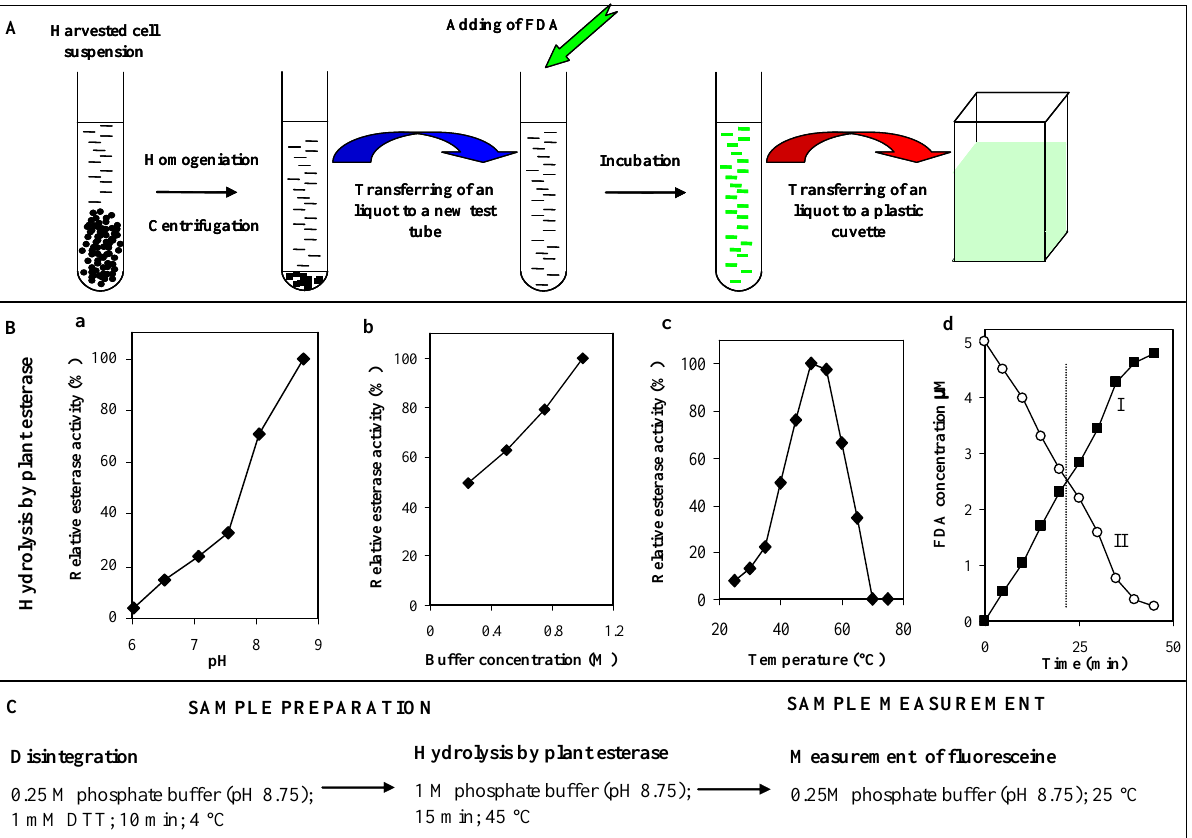
Figure 3. Optimization of the plant esterase determination. Scheme of a plant cells sample prior to analysis ( A ). FDA hydrolysis by plant esterases ( B ). The dependence of esterase activity of PE on pH ( a ), concentration ( b ) of phosphate buffer; and temperature ( c ). Relative esterase activity of 1.3 · 10 -5 IU (a), 8.9 · 10 -5 IU (b) and 4.8 · 10 -5 IU (c) corresponds to the 100 %. Influence of reaction time on FDA enzymatic and spontaneous hydrolyses ( d ). Time course of total (enzymatic and spontaneous together) hydrolysis (I). Curve (II) shows the time course of concentration of FDA in the reaction mixture. Vertical line indicates substrate depletion for the enzymatic reaction. Scheme of sample preparation and its measurements using the most effective experimental conditions ( C ). For other details, see Results and Discussion